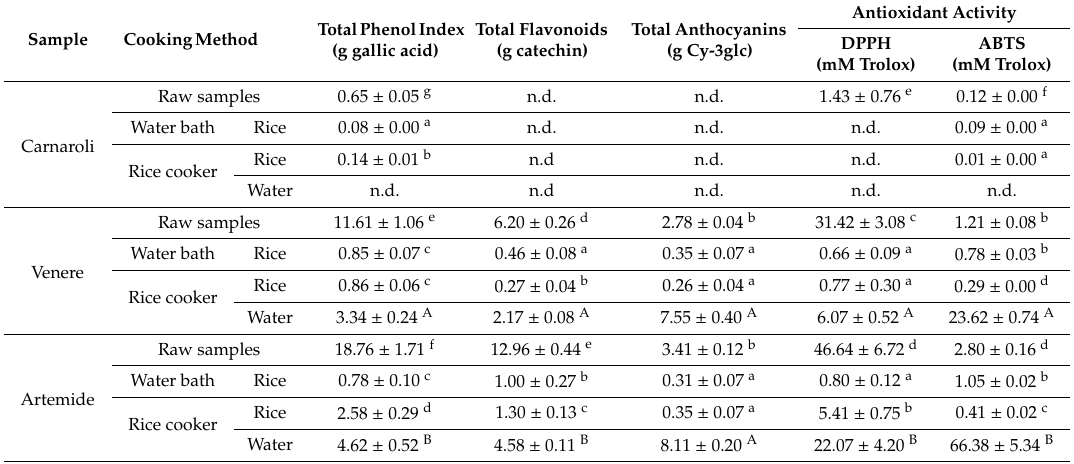
Table 3. Total anthocyanins and flavonoids content, total polyphenol index (TPI) and